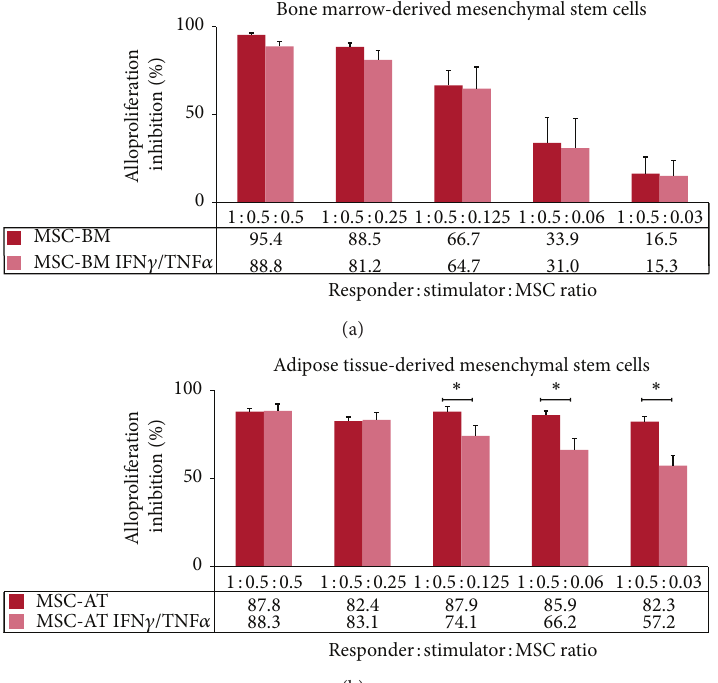
Figure 6: Both BM- andAT-derived MSCs display immunosuppressive properties in a dose-dependent manner. PBMC from healthy individuals were used as responder cells towards irradiated LCL ∗ used as stimulating cells in presence of either (a) BM-derived MSCs (MSC- BM) or (b) AT-derived MSCs (MSC-AT) that were pretreated with IFN 𝛾 and TNF 𝛼 (IFN 𝛾 /TNF 𝛼 ) or not and used as third-party cells at various responder: stimulator: MSC ratios. Results are given as mean percentage of alloproliferation inhibition ± s.e.m. according to the maximal alloproliferation observed with PBMC+LCL ∗ using PBMC from 4 and 6 distinct healthy donors in BM- and AT-derived MSCs experiments, respectively.